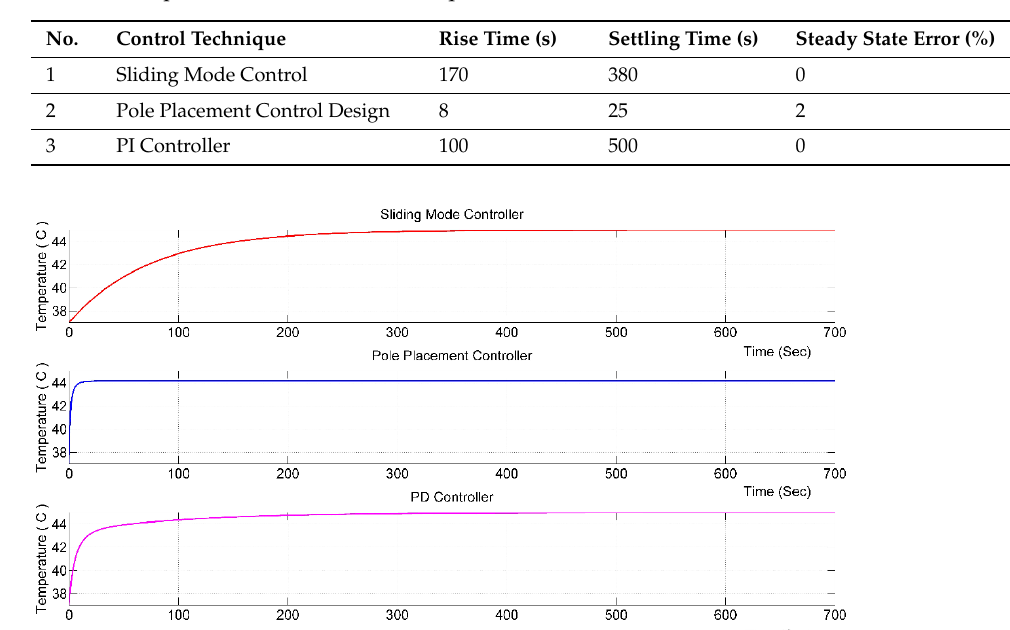
Table 2. Comparison of the control techniques.